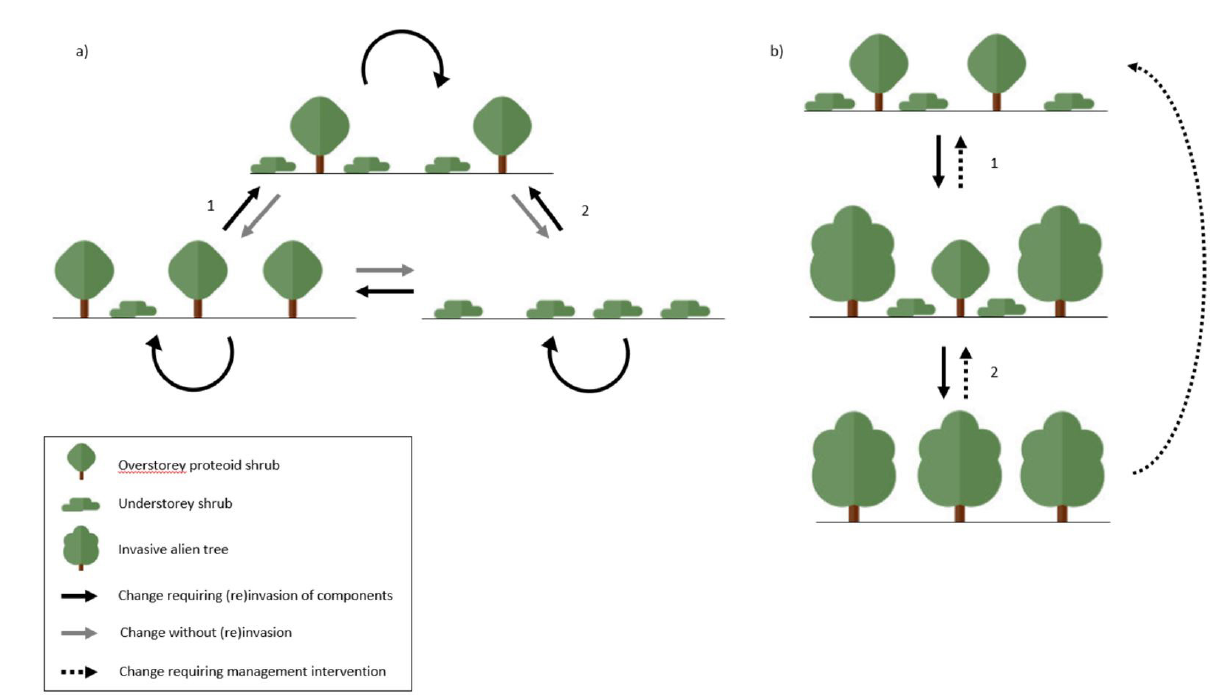
Figure 1. Schematic representation of disturbance-induced changes (e.g., fire) in the structure of native fynbos vegetation in (a) the absence of invasive alien trees, and (b) invaded by alien trees (inspired by Richardson and Cowling, 1992). In the absence of invasive alien trees, recruitment of overstorey shrubs (predominantly a proteoid component) is highly variable. They may proliferate and supress understorey species (a1). Adverse conditions during or after a disturbance event may result in poor recruitment or local exclusion of overstorey shrubs (a2). Once invasive alien trees (such as Australian Acacia species) are established in fynbos communities, their resilience to disturbances disrupts the natural successional processes. As the invasive alien trees proliferate (b2), they outcompete native species and alter the vegetation structure. Management interventions (dashed lines) are required to return the system back to the native state. CBA - Critical Biodiversity Area; ESA - Ecological Support Area (ESA); OESA - Other Ecological Support